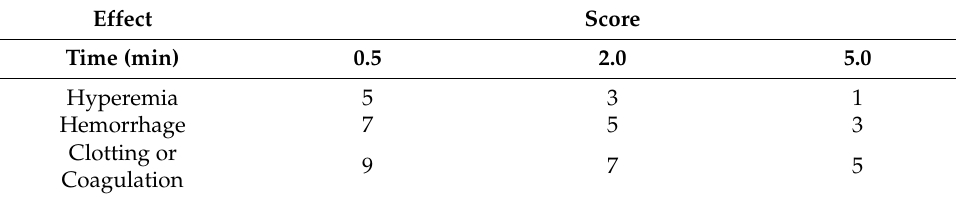
Table 1. Time-dependent numerical scores for each of the three irritant responses [39].